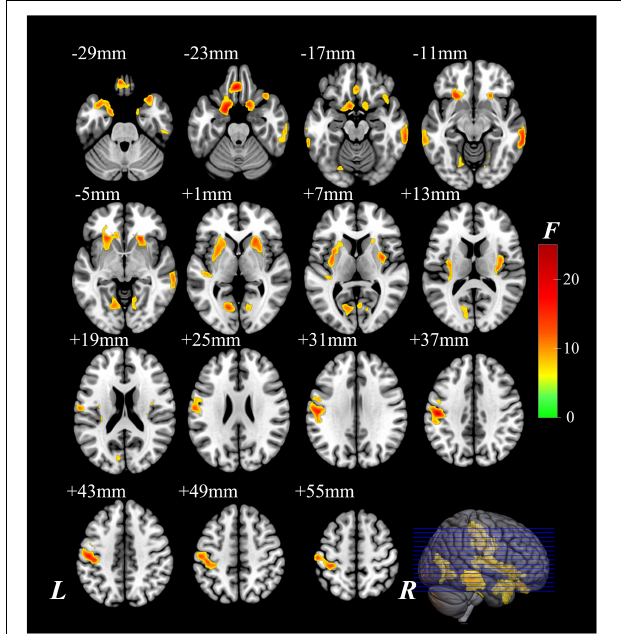
FIGURE 2 | The brain regions with significant differences of the CBF-ReHo ratio among groups. The voxel-based analysis demonstrates the survived clusters among HC, PD-NC, and PD-MCI groups. These clusters are referred to multiple comparisons correction using the FWE rate (a cluster-defining threshold of P = 0.001 and a corrected cluster significance of P < 0.05). The region with the significant difference among the three groups is shown with warm color. CBF, cerebral blood flow; ReHo, regional homogeneity; HC, healthy control; PD, Parkinson’s disease; NC, normal cognition; MCI, mild cognitive impairment; FWE, familywise error; R, right; L,